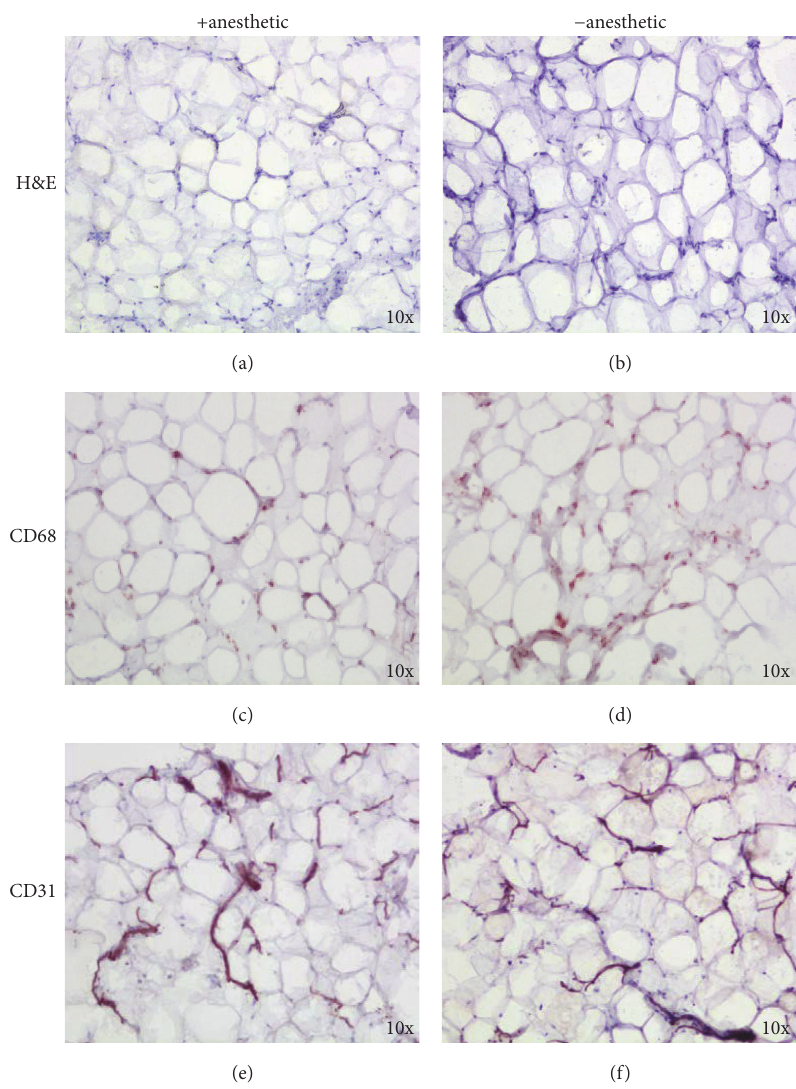
Figure 1: Local anesthetic did not interfere with adipose tissue morphology. H&E staining showed a similar morphology of adipose tissue harvested with or without local anesthetic. No evidence of adipose tissue degeneration or necrosis was evident (a, b). IHC analysis showed comparable staining for CD68 and CD31, in both samples harvested with or without anesthetic